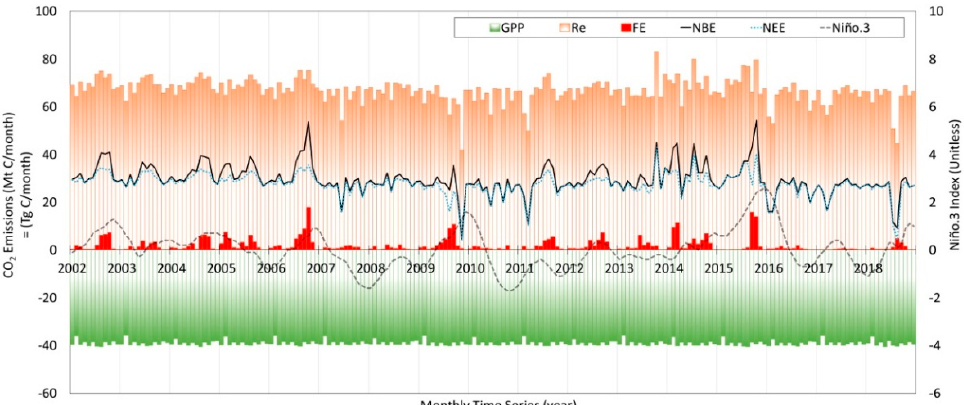
Figure 12. Monthly time series of the GPP, R e ( UF ), FE, NBE, net ecosystem CO 2 exchange (NEE) ( R e − GPP), and the Niño.3 index from 2002 to 2018. GPP, R e , FE, and NBE refer to primary axis (left) with negative signs for the GPP and positive signs for the rest. The Niño.3 index is listed on the secondary axis (right). The net CO 2 balance is positive, indicating that the tropical peatlands are net sources of CO 2 . The temporal fluctuation of FE seems to be the dominant factor to change the NBE. In addition, FE usually appeared in the on-set of the Niño.3